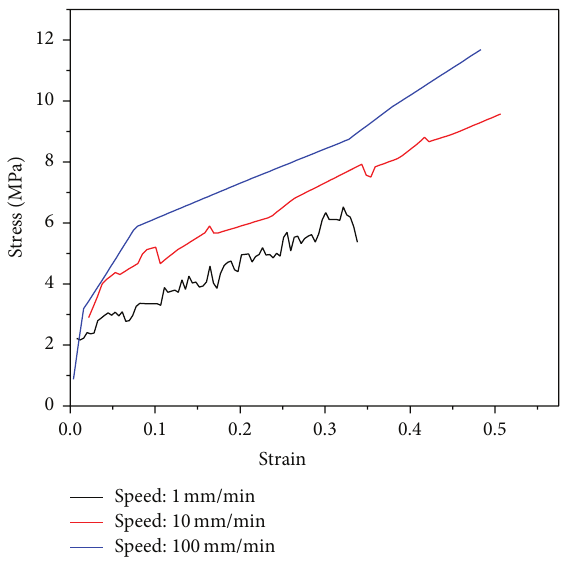
Figure 4: Typical representative stress strain curves for PVA samples at different constant speeds.